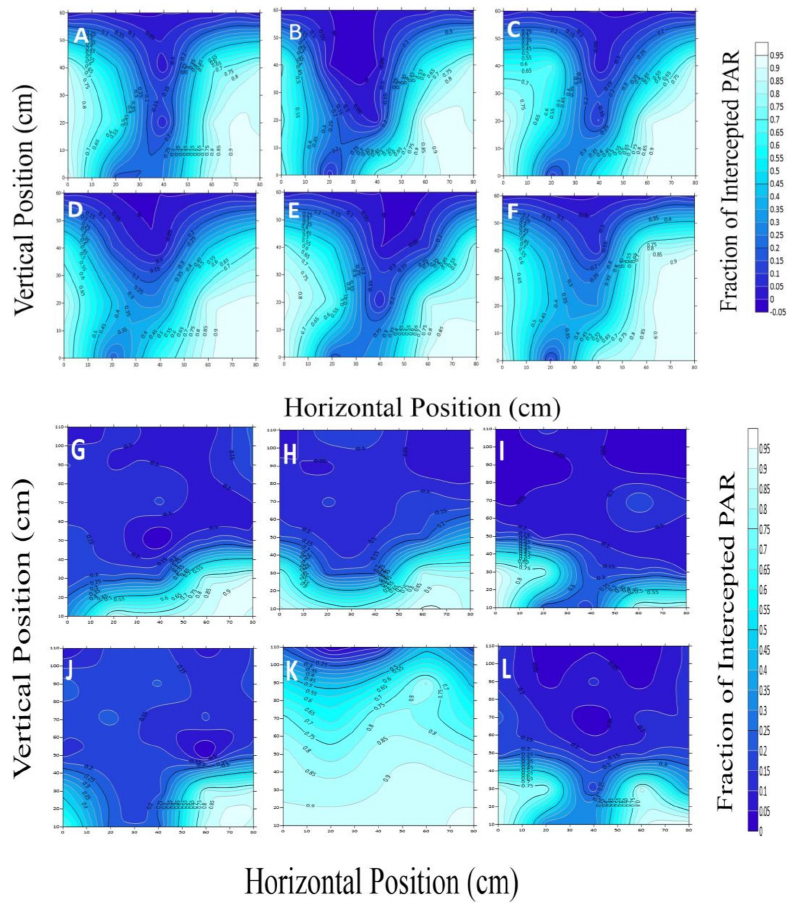
Figure 3. Vertical and horizontal distribution of iPAR at the squaring stage for OShi, Ji228, SCRC28, CCRI 3799, CCRI50, and CCRI60 in 2018 ( A – F ) and 2019 ( G – L ). The cotton branches started expanding simultaneously with the leaf area, resulting in the canopy being compact, which caused drastic changes in the structural dissemination of the iPAR. In the 20 cm and 60 cm horizontal positions, closest to the lines of cotton, the range of iPAR values, starting from the lowest point to the upper point of the canopy, were 0.09–0.93 (Ji228), 0.01–0.82 (CCRI60), and 0.01–0.94 (CCRI50). In the middle position (40 cm), Ji228, CCRI60, and CCRI50 were approximately 0.50–0.91, 0.09–0.77, and 0.09–0.94, respectively. In the opposite direction, the iPAR values in the Ji228 canopies were 0.01–0.85 and 0.02–0.93 at 20 cm and 60 cm, respectively. At the 40 cm vertical point, the middle lines, the iPAR values ranged from 0.18 to 0.91. At the bottom of the canopy of CCRI50 and CCRI60, the light interception ranged from 0.09–0.93 and 0.01–0.82, respectively. However, it was approximately 0.01–0.86 (CCRI50) and 0.20–0.76 at the mid-point (40 cm vertical position)